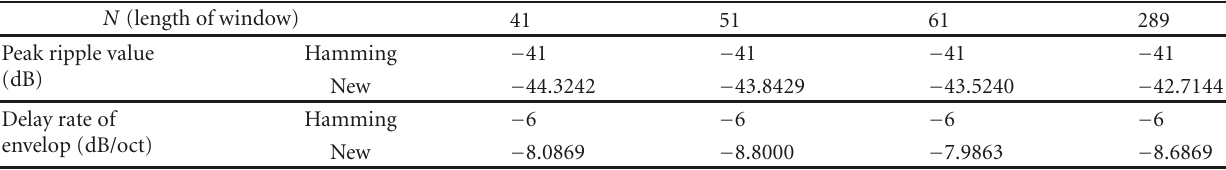
Table 2: New window parameter improvement.